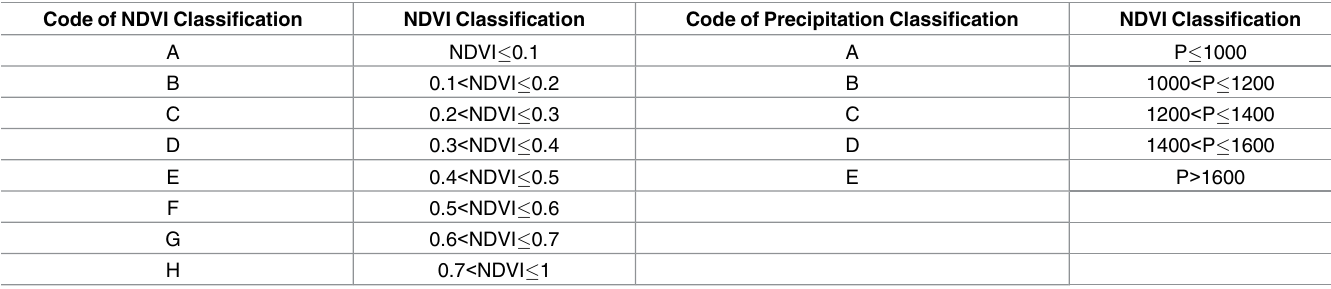
Table 5. Classification of NDVI and precipitation amounts in our study. Code of NDVI